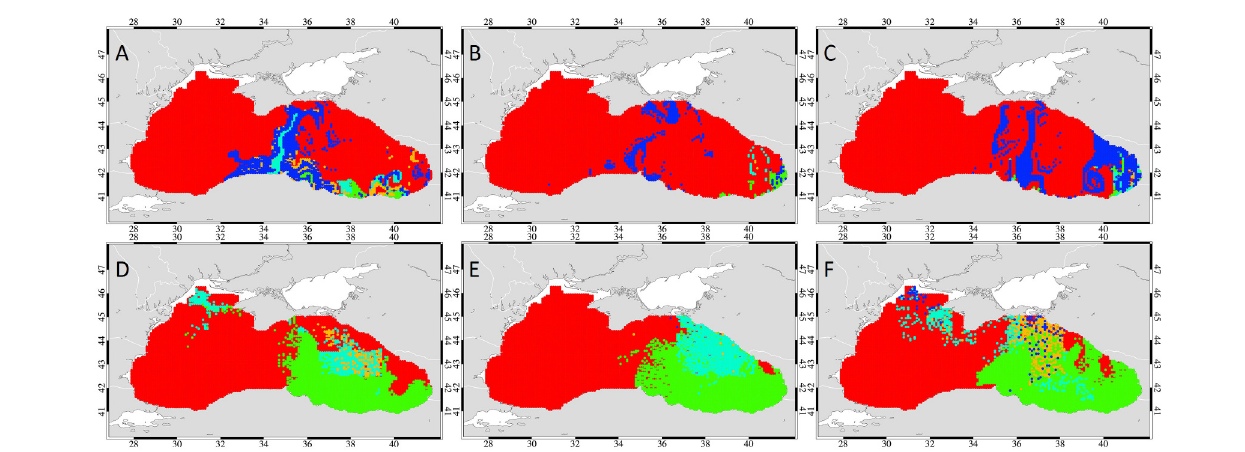
FIGURE 9 | Simulations of interannual variability: The start points of 7176 drifters released at the end of October in the advection only simulation (A–C) and in the temperature gradient simulation (D–F) in 2001, 2002, and 2003 (left, middle, and right column). The start points of drifters that complete successful migration in 2, 4, 6, and 8 weeks are color-coded green, cyan, yellow, and dark blue, respectively. The start points of the drifters that do not reach the overwintering grounds are marked red.